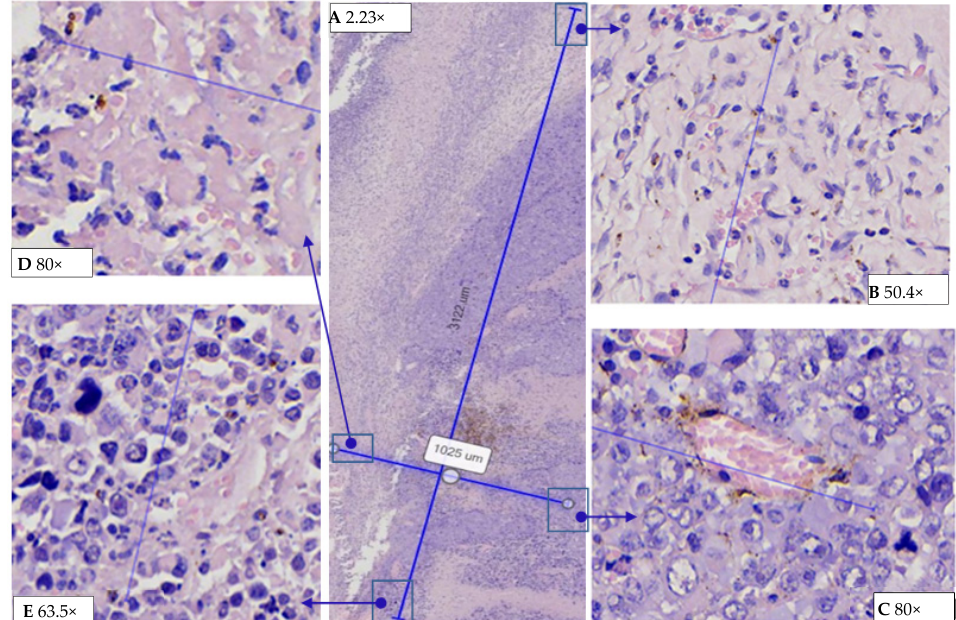
Figure 10. Photomicrographs demonstrate histopathological effect in a tumor following EcPHL vaccination and intratumoral mNP injection (6 h prior sampling). There is significant tumor necrosis ( A , D ) as well as early fibrous infiltration ( B ) and macrophage -tumor cell intermixing ( C , E ). ( C ) demonstrates the accumulation of mNP around a tumor blood vessel. Group III mouse. H&E staining. ( A ) magnification: length, 3.122 µm; width, 1.025 µm. Overall, a histological examination of tumor tissue samples indicates that EcPHL- and mNP-treated mice had greater numbers of mNP-carrying macrophages. These